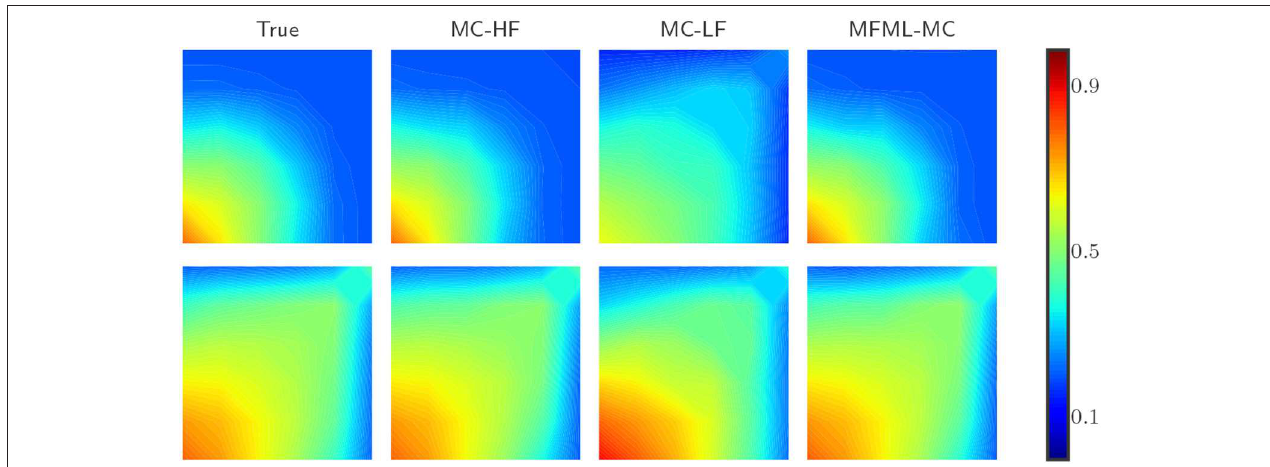
FIGURE 4 | Test case 1: Comparison of estimation of E [ u t ] (mean water saturation field at 6 number of MC realizations that uses only high-fidelity model. (Top Row) Estimation of E [ u t ] at time t